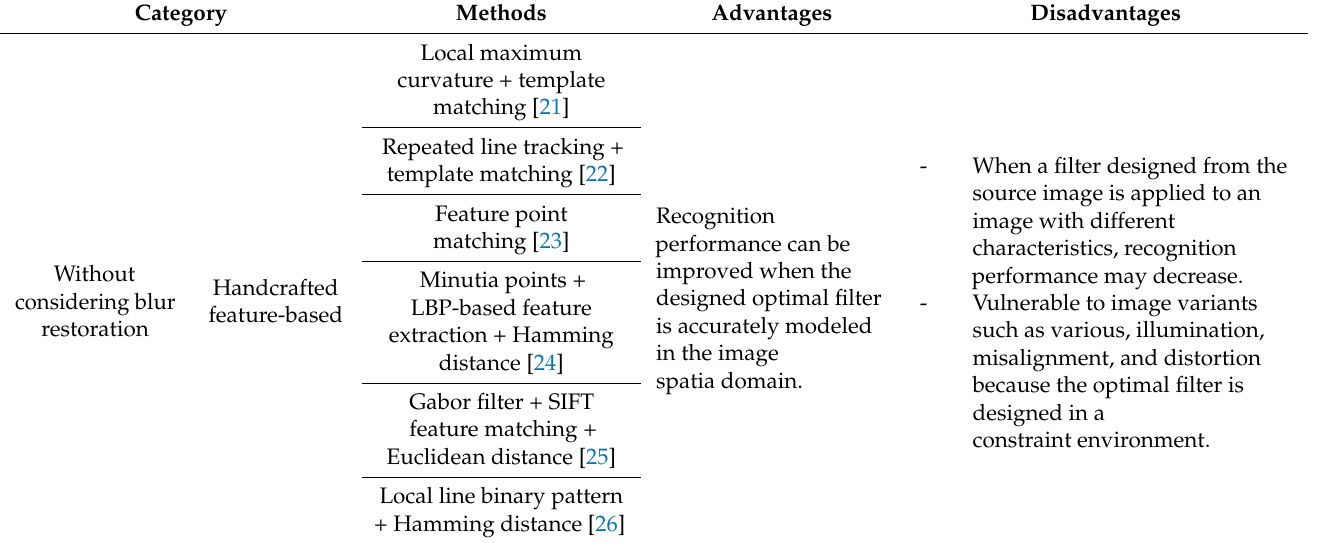
Table 1. Comparisons of the previous and proposed finger-vein image restoration